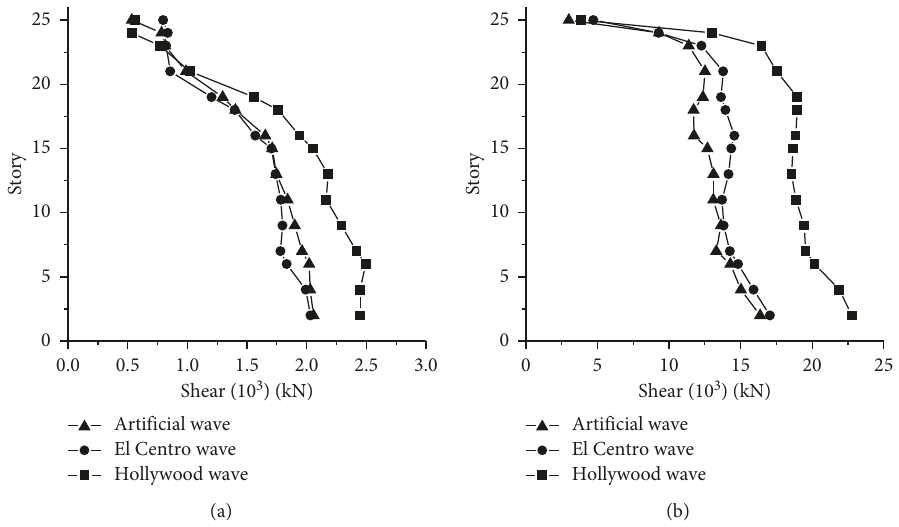
Figure 18: Story maximum shear of normative model. (a) Frequent intensity 7; (b) rare intensity 7.